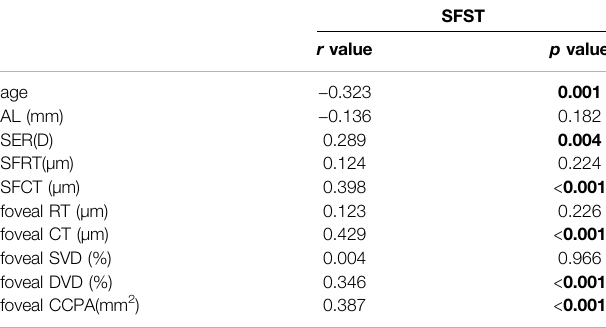
TABLE 5 | Linear correlation analysis between SFST and ocular